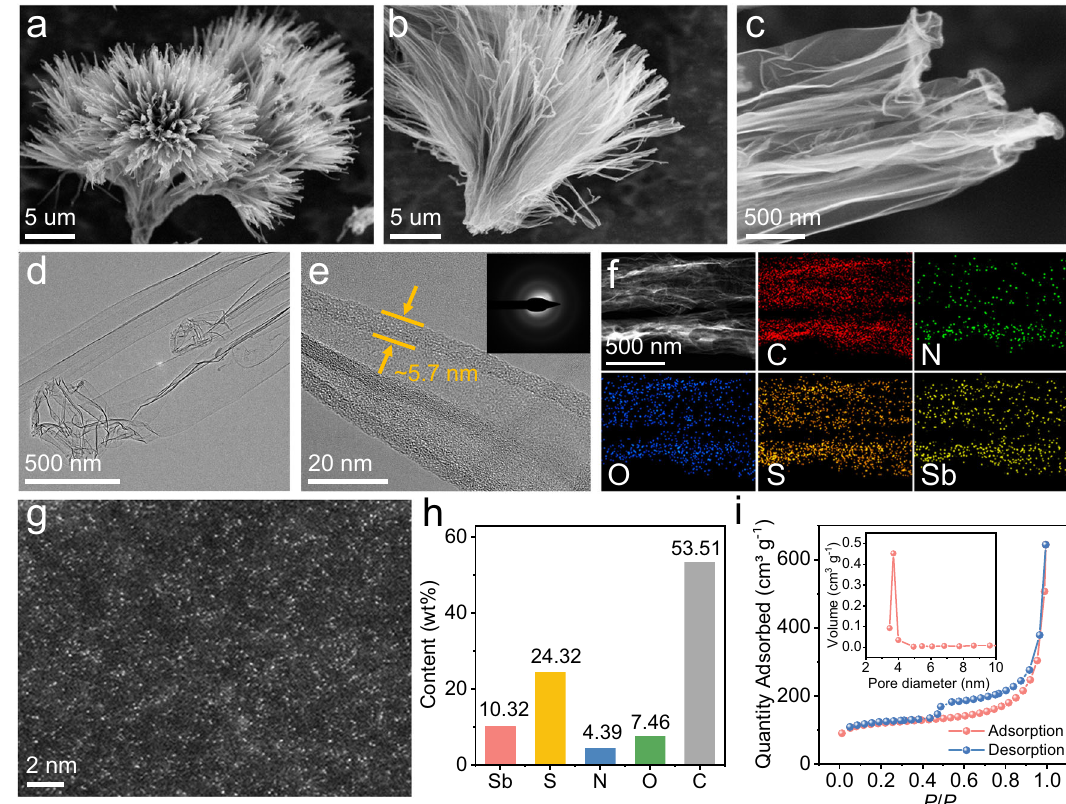
Fig. 2 | Characterizations of the morphology and structure of Sb-NSCF. a Top- view SEM image of Sb-NSCF. b Side-view SEM image of Sb-NSCF. c Enlarged view in ( b ), showing the morphology of the hollow carbon nano fi bers. d , e TEM images of Sb-NSCF at different magni fi cations. Inset of e shows the SAED of Sb-NSCF, sug- gesting the amorphous nature of the carbon shells. The thickness of the carbon shells is ~5.7nm. f EDS elemental mapping of Sb-NSCF, suggesting the uniform